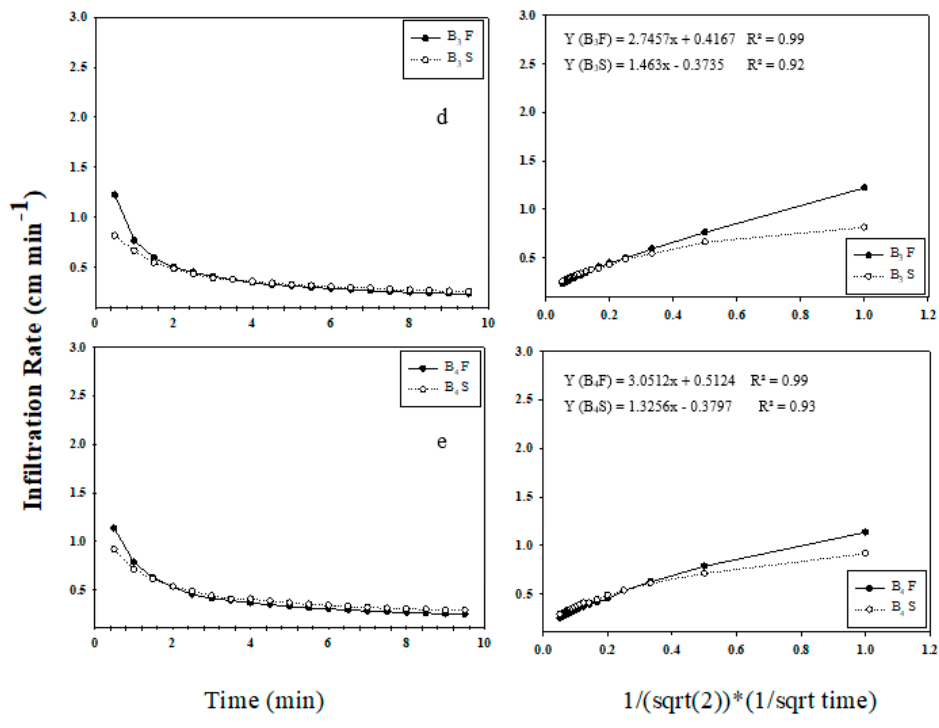
Figure 3. ( a – e ) Effect of soil conditioners (biochar) application on infiltration rate. C denotes the control soil and B denotes the soil with biochar application rates of 1, 2, 3, and 4. F and S denote fresh and saline water, respectively.